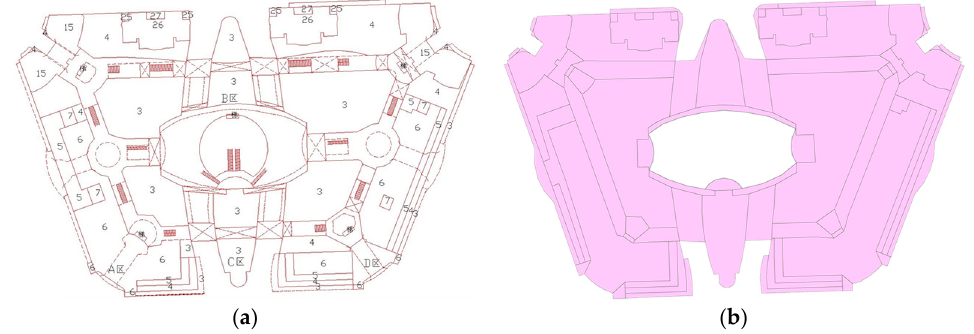
Figure 21. All the property objects of Pozi Street: ( a ) contours of all the property objects and ( b ) footprints shown as different floors.